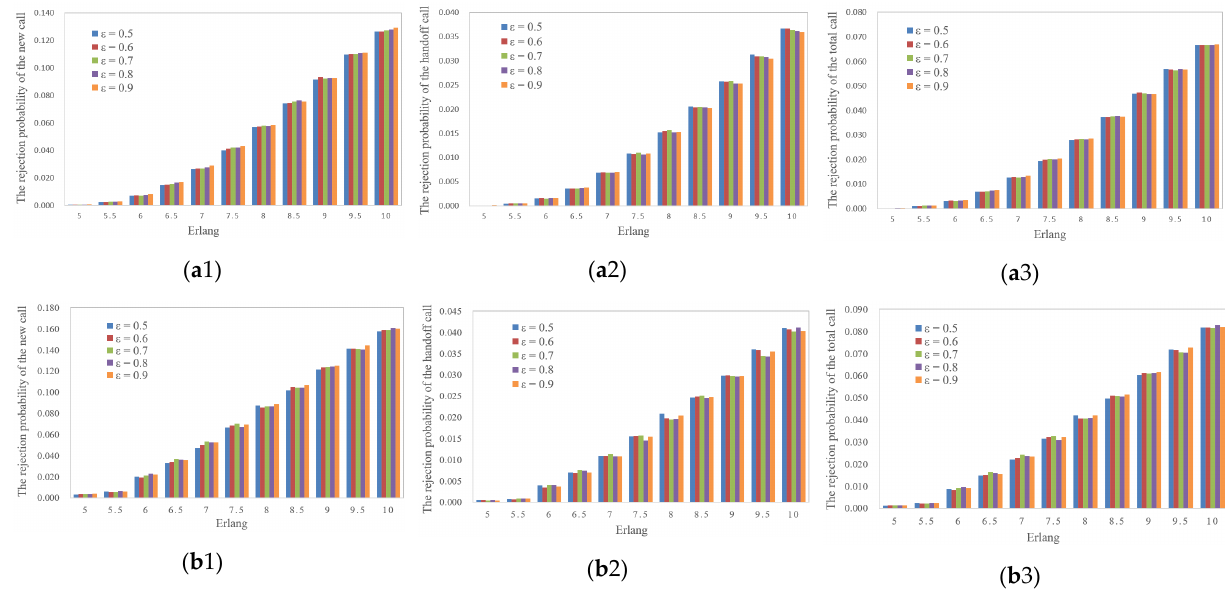
Figure 6. Performance comparison of TSCA with different values of epsilon. ( a 1) The rejection probability of the new call under uniform distribution; ( a 2) the rejection probability of the handoff call under uniform distribution; ( a 3) the rejection probability of the total call under uniform distribution; ( b 1) the rejection probability of the new call under nonuniform distribution; ( b 2) the rejection prob ‐ ability of the handoff call under nonuniform distribution; ( b 3) the rejection probability of the total call under nonuniform distribution.